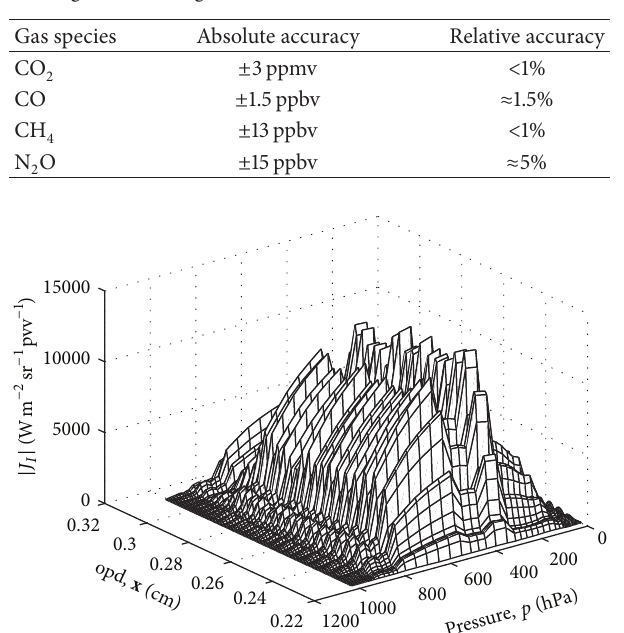
Figure 3: Mesh surface of 𝐽 𝐼 . The Jacobian derivative of the interferogram radiance with respect to the mixing ratio profile of CO.